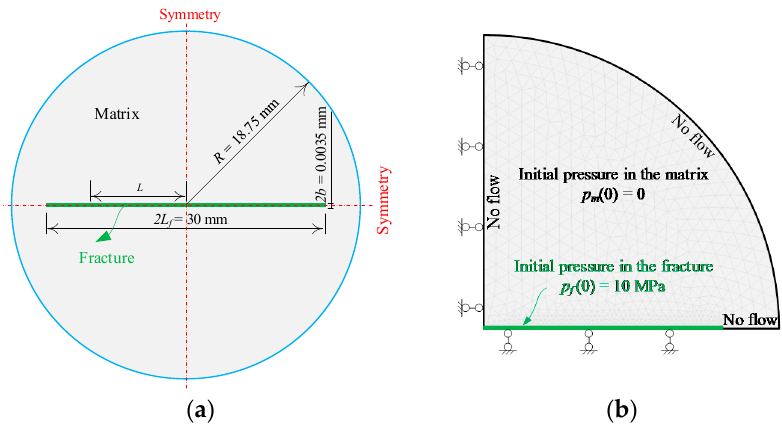
Figure 18. Verification model. ( a ) Typical section of coal sample; ( b ) Model implemented in the simulation.